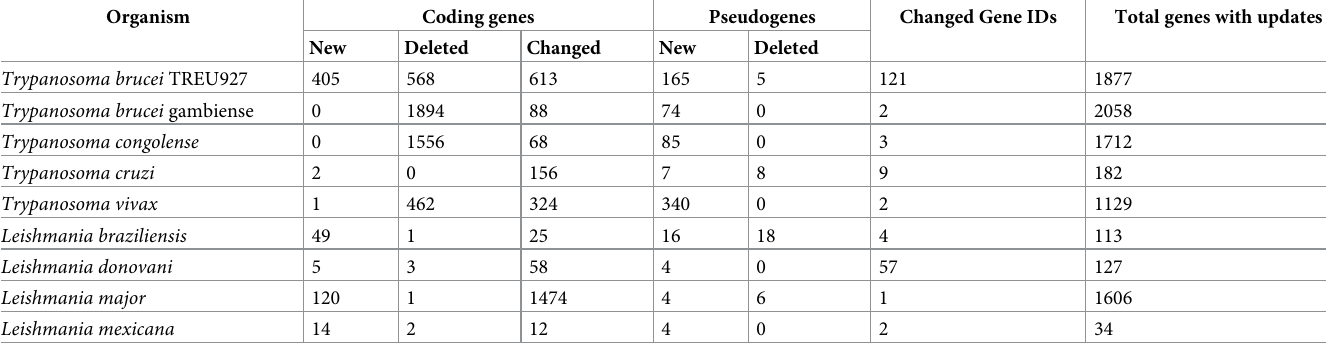
Table 2. Summary of structural annotation changes for curated organisms since the initial integration of genomes in TriTrypDB. Organism Coding genes Pseudogenes Changed Gene